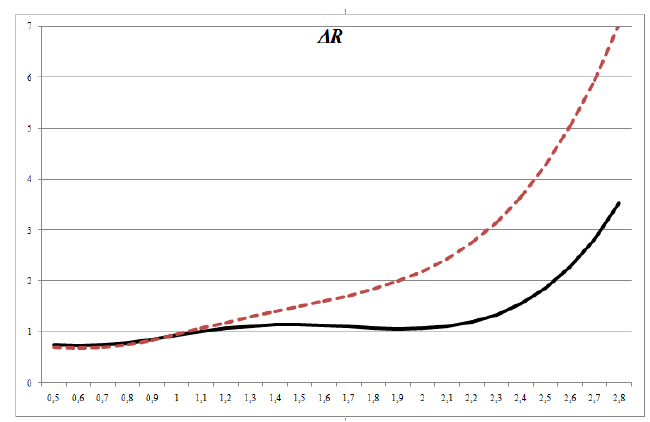
Figure 3 . Functional relationships between the variable Δ R and the dependent variable Δ Y concerning a variation of the variable total property tax equal to 105% (continuous black line) and in the absence of variations of the variable total property tax (broken red line).